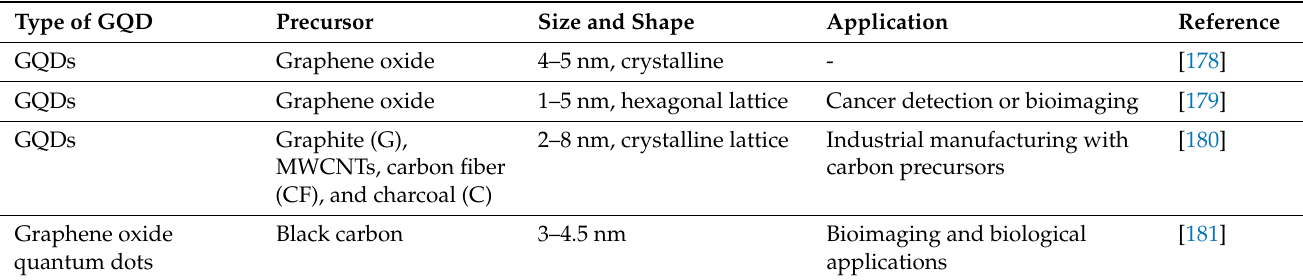
Table 9. The acid-free methods for the preparation of